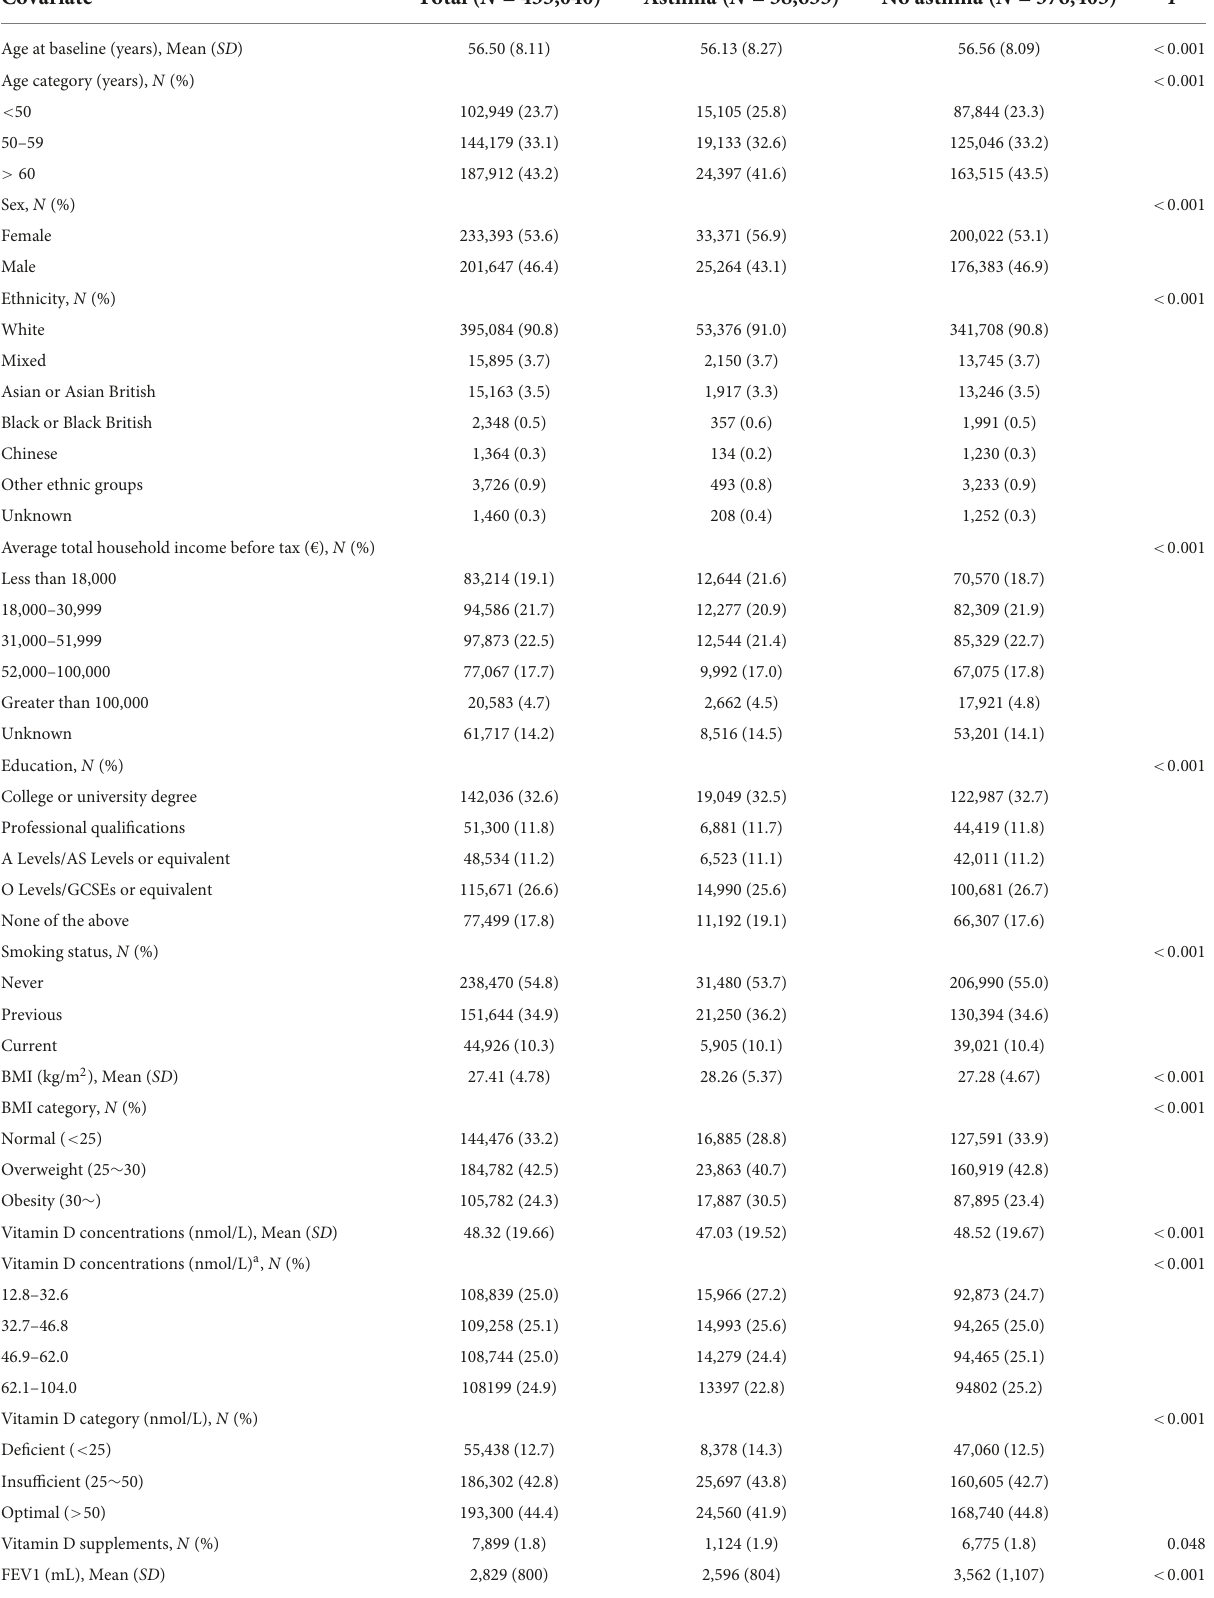
TABLE 1 Characteristics of the included participants from the UK